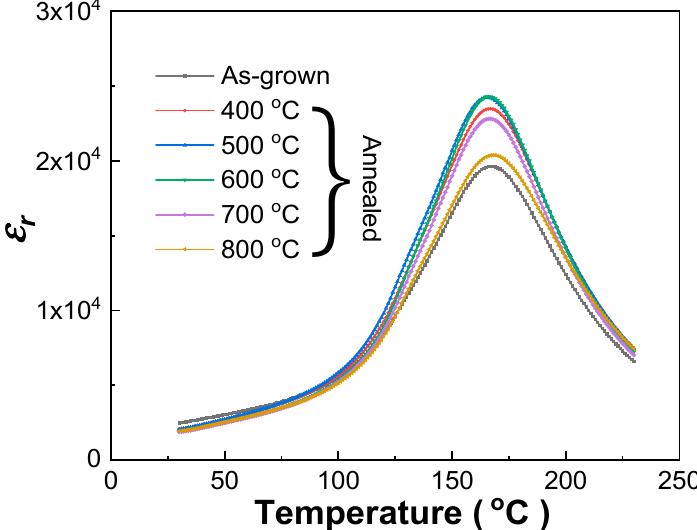
Figure 4. Dielectric constant (1 kHz) versus temperature of the unpoled Mn:PIMNT single crystals annealed at different temperatures upon heating. Table 3. Dielectric parameters of the Mn:PIMNT crystals annealed at different temperatures. Annealed As-Grown